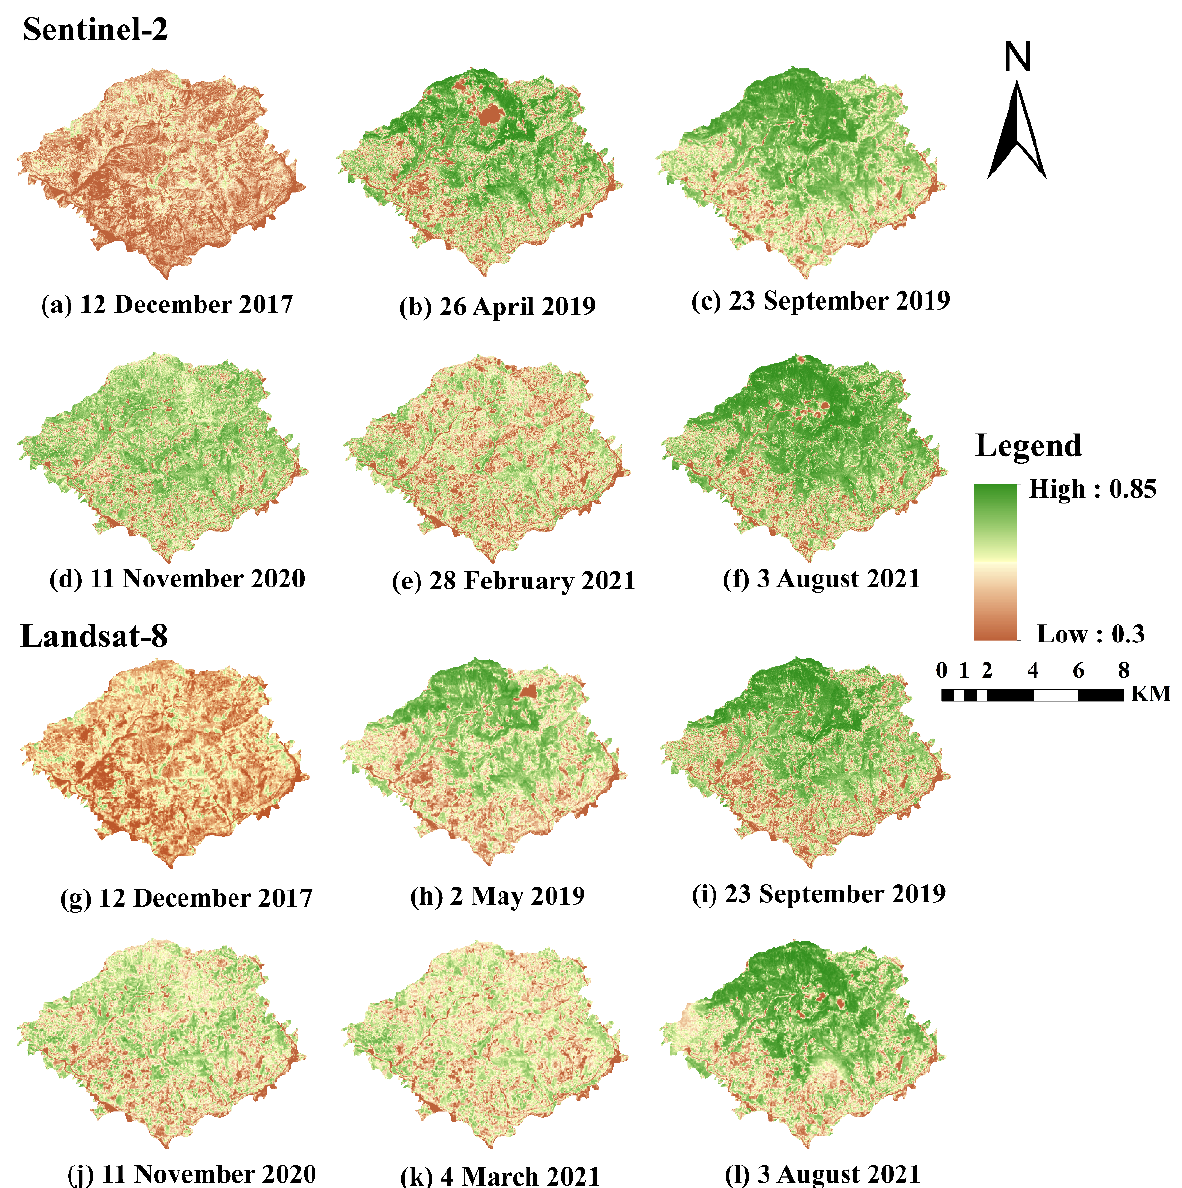
Figure 2. Multitemporal images of normalized difference vegetation index (NDVI) from Sentinel-2 and Landsat 8, respectively.